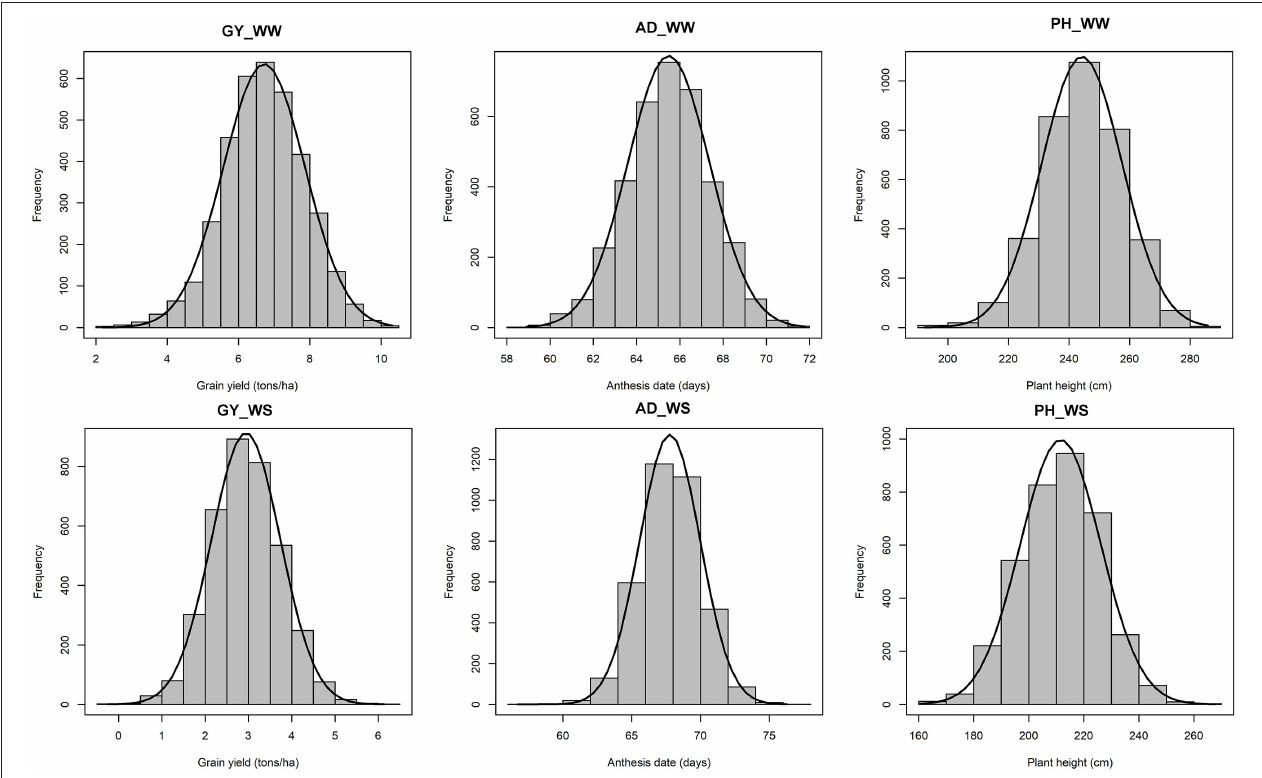
FIGURE 1 | Phenotypic distribution of GY, AD, and PH under optimum (top) and managed drought (bottom) conditions. GY, grain yield; AD, anthesis date; PH, plant